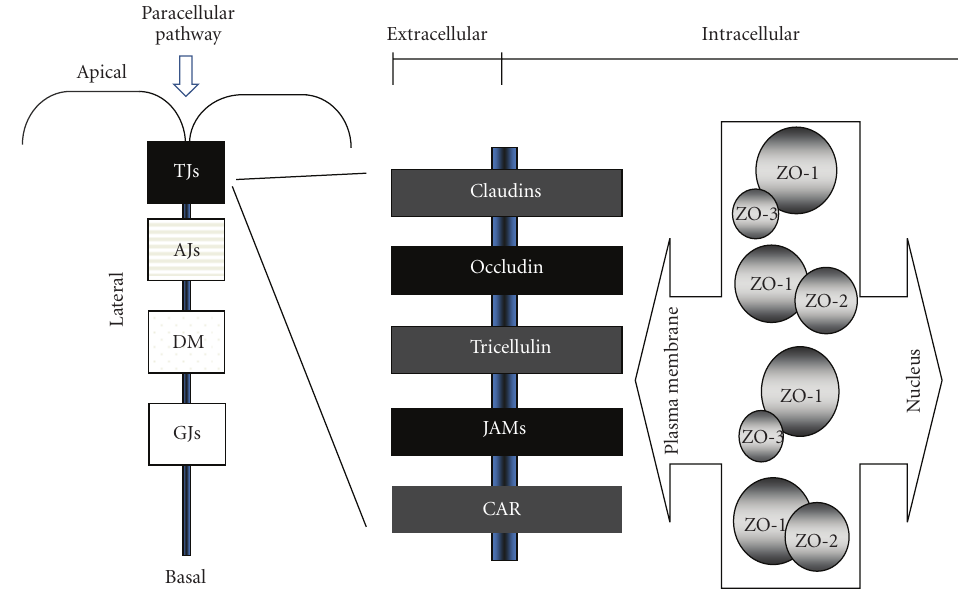
Figure 1: Localization of zonula occludens (ZO) proteins at tight junctions (TJs) . Transmembrane components of TJs interact at least with one ZO protein. As mentioned in the text, only ZO-1 and ZO-2 localize to the nucleus, while nuclear targeting of ZO-3 has not been observed so far. Already described interactions of ZO proteins with other types of junctions is not included here. TJs: tight junctions; AJs: adherens junctions; DM: desmosomes; GJs: gap junctions; CAR: coxsackievirus and adenovirus